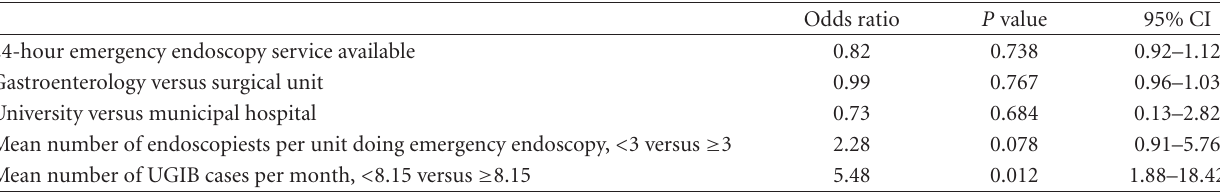
Table 3: Multiple logistic regression module of selected factors for the use of combined haemostatic methods followed by bolus plus continuous infusion of PPI in high-risk ulcer